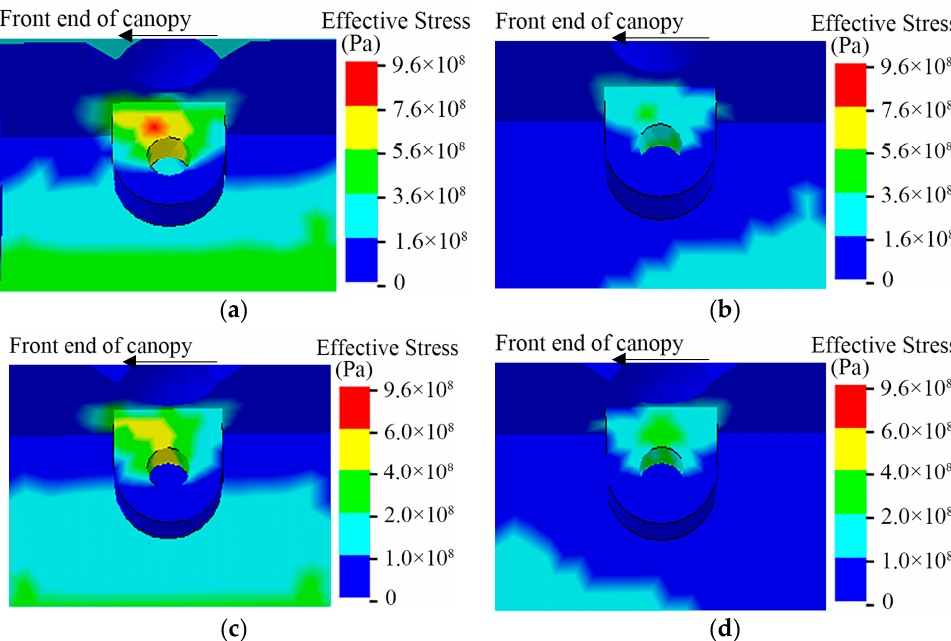
Figure 7. ( a ) Stress distribution of the hinged hole of the front column under impact load. ( b ) Stress distribution of the hinged hole of the rear column under impact load. ( c ) Stress distribution of the hinged hole of the front column under normal load. ( d ) Stress distribution of the hinged hole of the rear column under normal load.